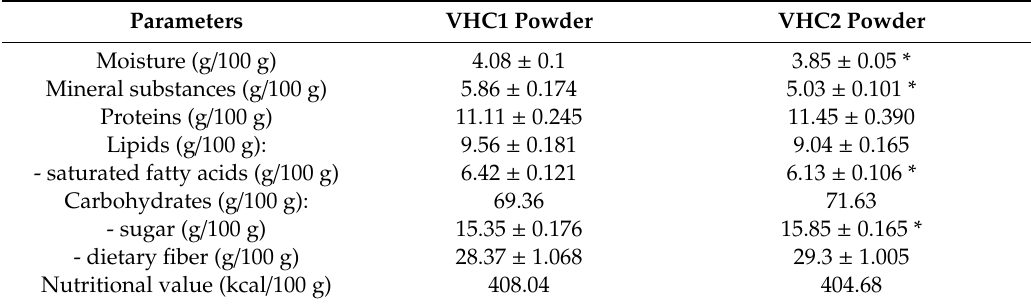
Table 5. Proximate composition of final